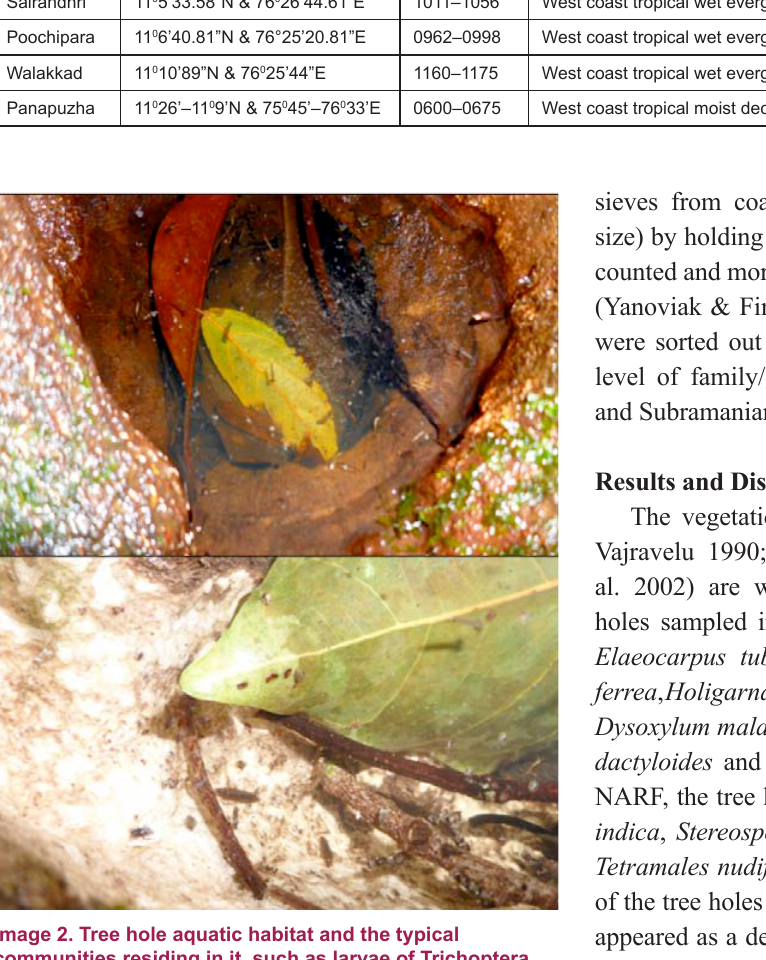
Table 1. Details of sampling locations in Silent Valley National Park and New Amarambalam Reserve Forest Place Location Altitude